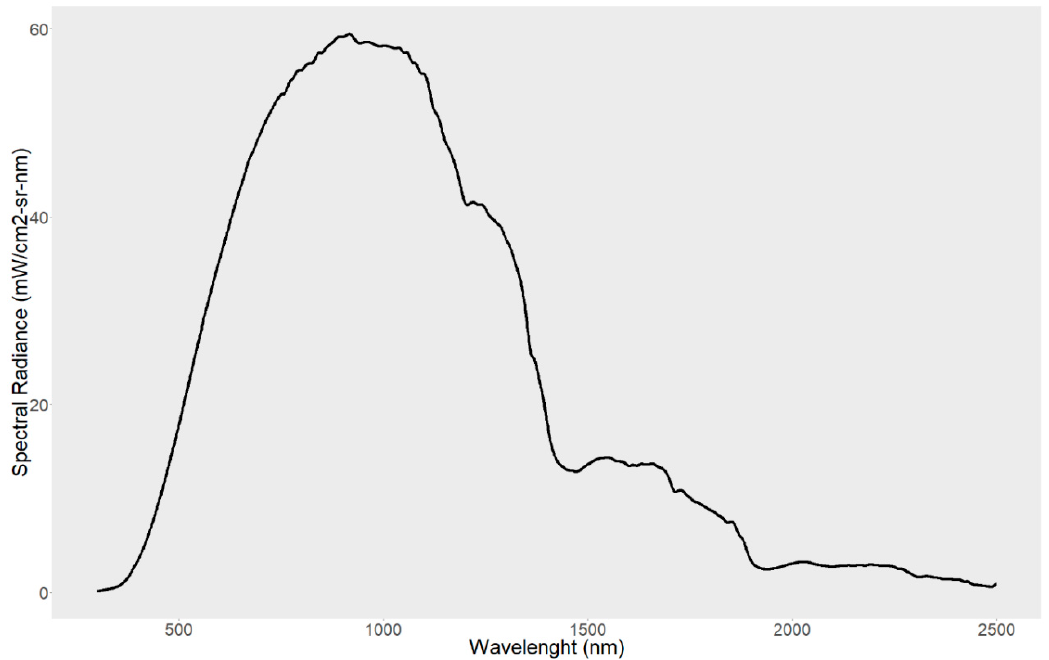
Figure 4. CSTM-LR-20-M integrating sphere spectral radiance curve from 300 nm to 2500 nm with maximum radiance around 900 nm.